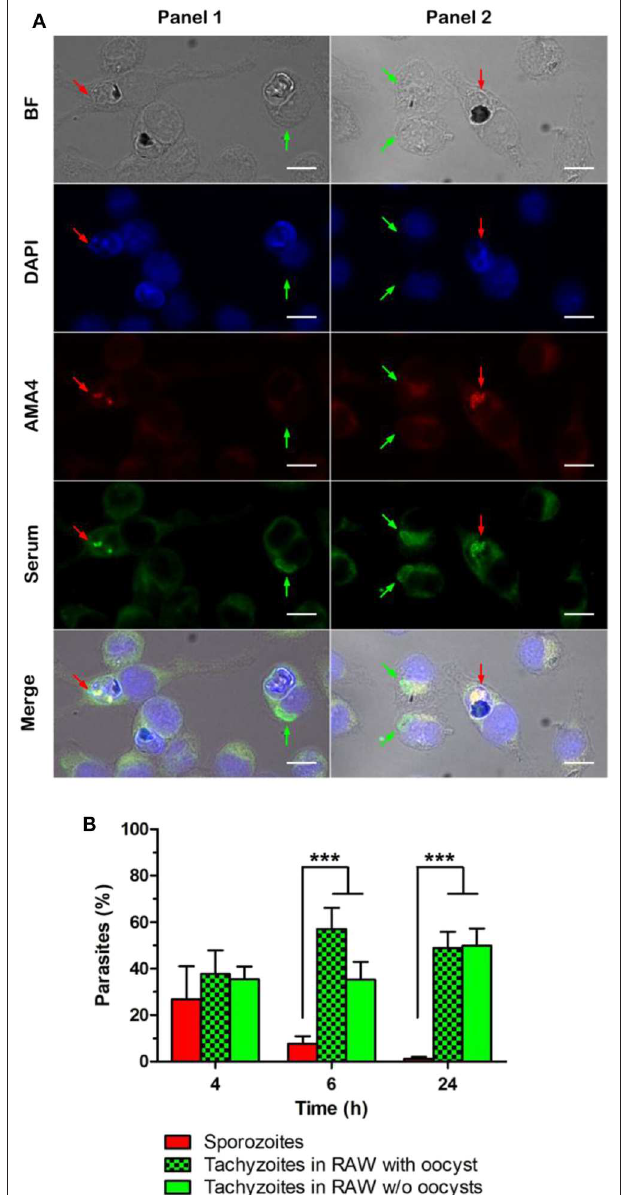
FIGURE 3 | Detection of sporozoites and tachyzoites of Toxoplasma gondii after 4, 6, and 24h of oocyst-RAW macrophage co-incubation . (A) Representative example of the immunolabelling of sporozoites (red arrow) and tachyzoites (green arrow) whether present in macrophages with oocyst remnants (Panel 1) or in macrophages without visible oocyst remnants (Panel 2) after 4h of oocyst-macrophage co-incubation. DAPI, macrophage nucleus and natural fluorescence of oocysts; AMA4, sporozoites; serum, sporozoites and tachyzoites. Scale = 10 µ m. (B) Percentage of sporozoites (red bar) and tachyzoites [whether present in macrophages with visible oocyst remnants (green and black checker) or in macrophages without oocysts (green)]. Mean ± standard deviation of 3 independent experiments. One-way ANOVA and Tukey’s post-test, *** p < 0.001.